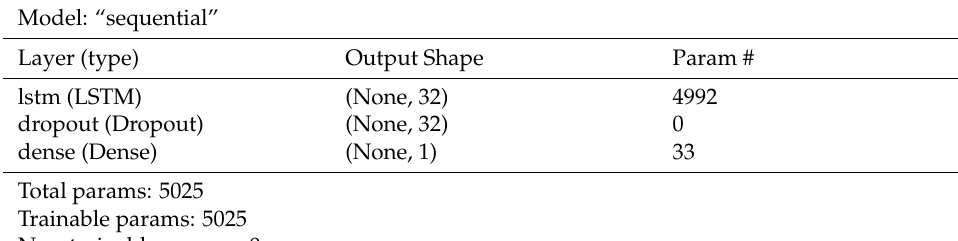
Table 4. Information was consolidated following the formation of the first layer.